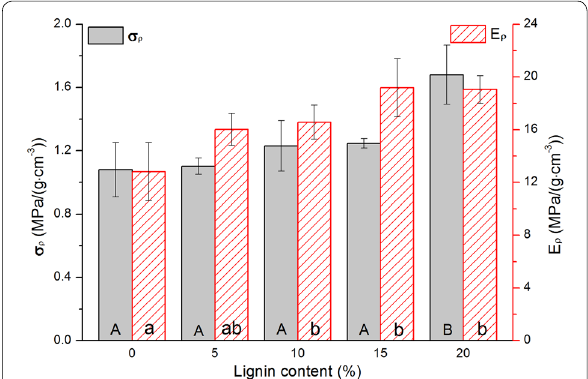
Fig. 6 Specific compressive strength ( σ ρ ) and modulus ( E ρ ) of the W–PU foams containing varying contents of lignin perpendicular to foam rise. Different letters represent statistically significant difference between groups ( p < 0.05)